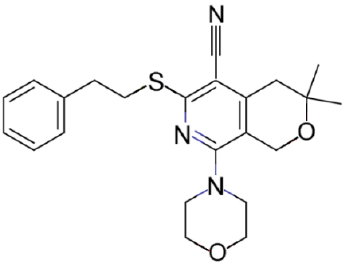
Figure 7. Chemical structure of MBX2319.